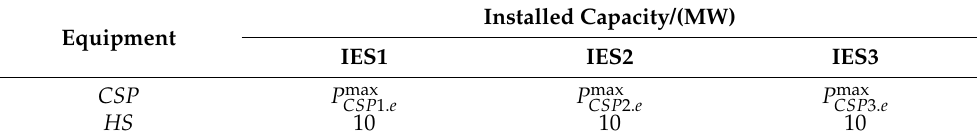
Table 5. CSP installed capacity.